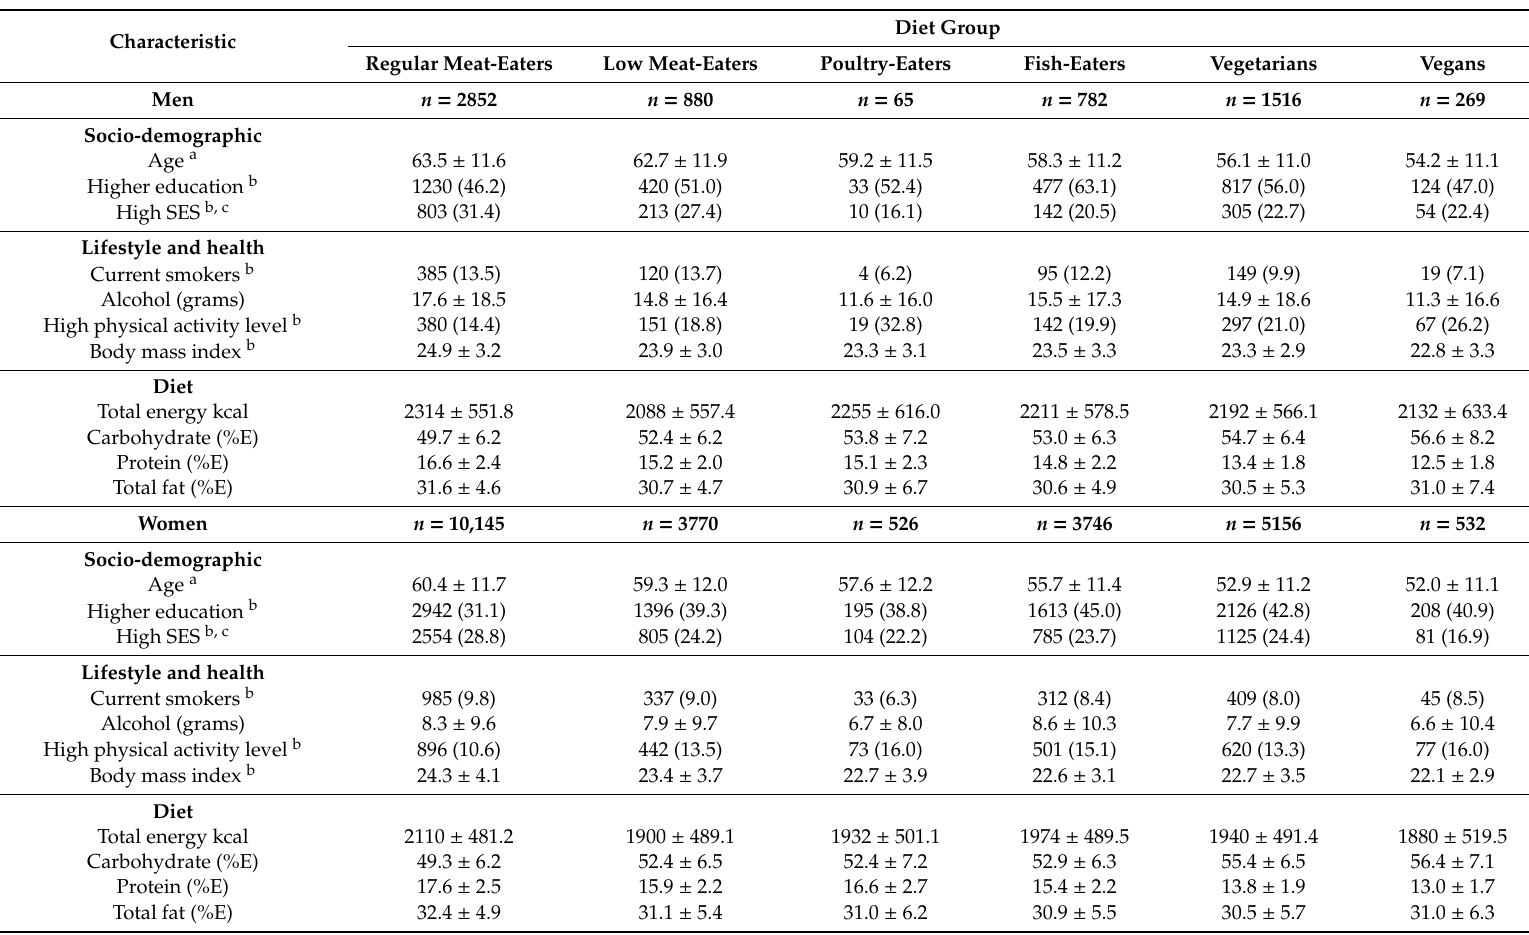
Table 1. Baseline characteristics of men and women in European Prospective Investigation into Cancer and Nutrition (EPIC)-Oxford by diet